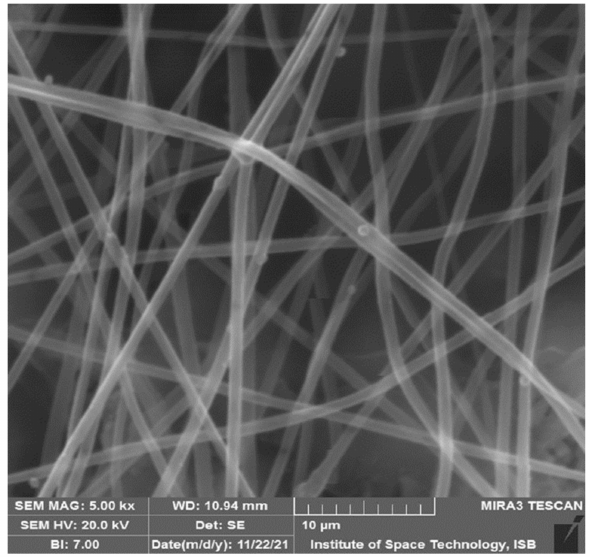
Figure 8. Pure CA SEM